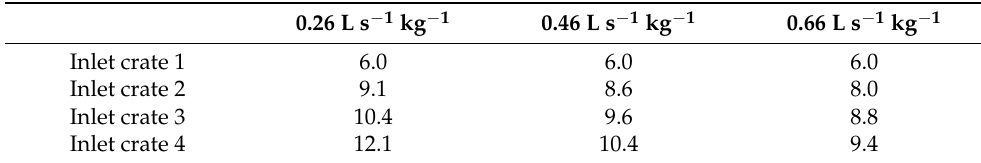
Figure 13. Influence of the airflow rate on the temperature uniformity of the products packed in the crates (crate B). Table 4. Average air temperature in ◦ C at the inlets of the 4 crates for different airflow